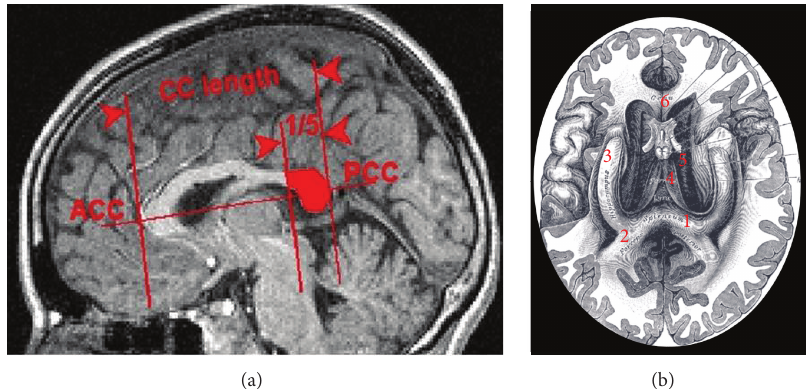
Figure 1: Midsagittal and axial views of the splenium. (a) Midsagittal T1-weighted MRI shows the corpus callosum (CC) and the splenium (in red). According to the conventional partitioning scheme, the splenium corresponds to the posterior 1/5 of the CC, which is separated by the border line perpendicular to the line linking the most anterior (ACC) and posterior (PCC) points of the CC. (b) Axial view of the splenium (1) from Gray’s Anatomy of the Human Body. The numbers refer to the posterior forceps (2), hippocampus (3), fornix (4), undersurface of the CC (5), and genu of internal capsule